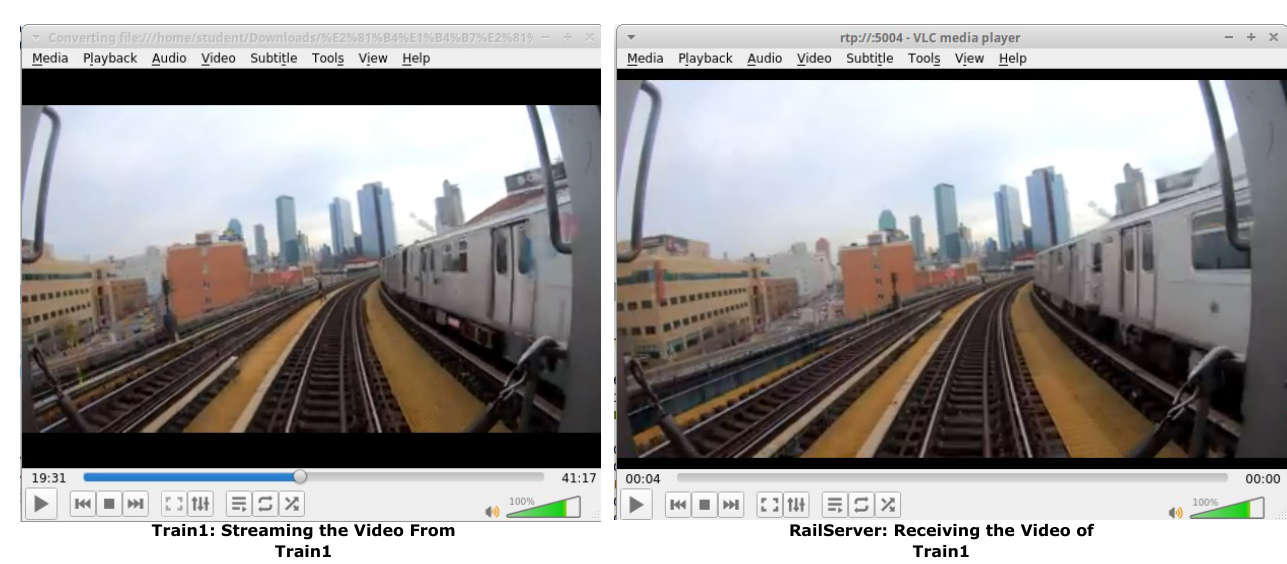
Figure 38. Video data transmission and reception